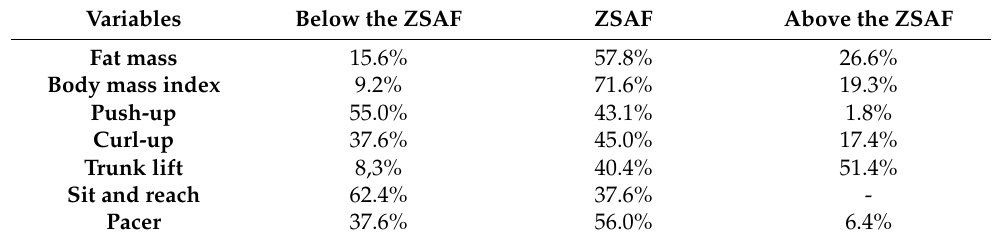
Table 4. Categorization of the variables under study in relation to Fitnessgram healthy fitness